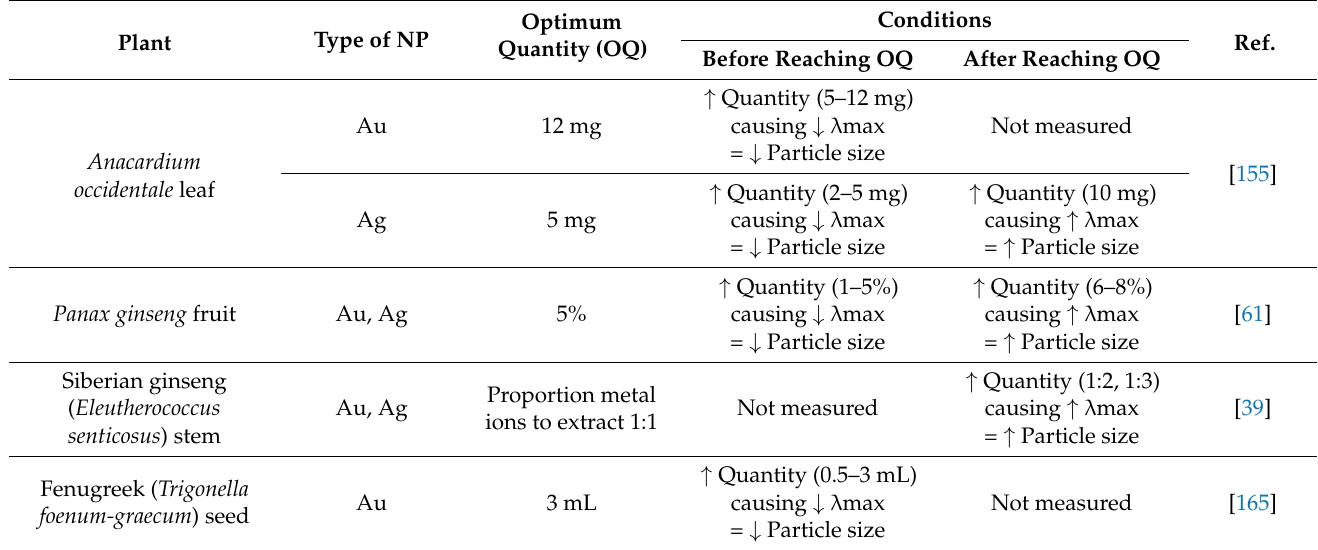
Table 9. Effect of concentration on the characteristics of AuNPs and